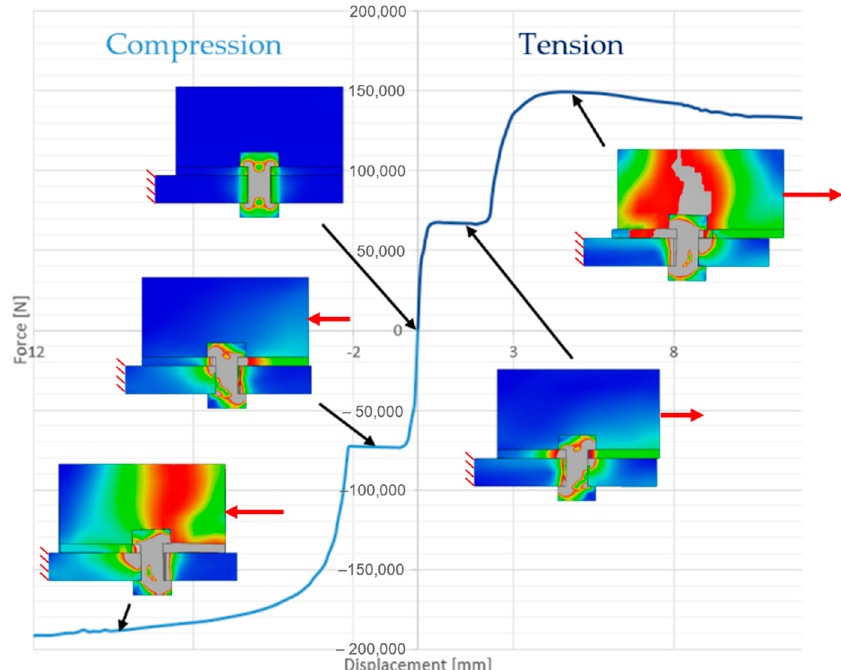
Figure 8. Example of load–displacement curves (stiffness functions are their derivative with respect to displacement) for tension and compression in a single bolt joint (in grey: the elements over the limit at 420 MPa). (The direction of the arrows represents the direction of loads, and the color from blue to red represents the equivalent stress value from low to high).